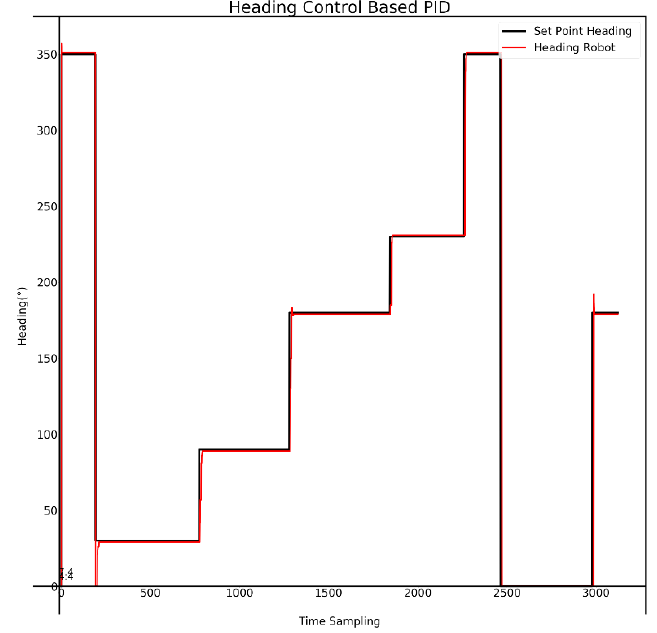
Figure 16. PID-based Heading Control System Response to Input Changes.